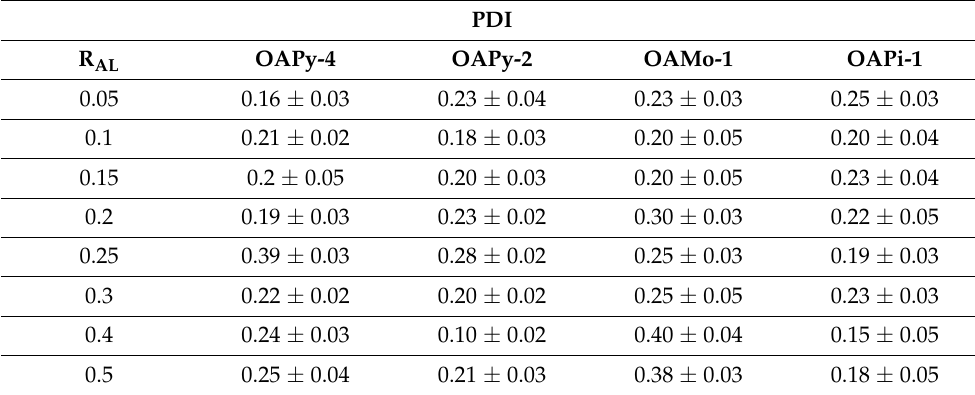
Table 2. Particle size distribution as expressed by polydispersity index (PDI) for nanoformulations prepared by adding aminolipids to MO dispersed with stabiliser Pluronic F-127. The amount of aminolipid added to the formulation is represented by R AL , which is defined as the wt./wt. ratio of aminolipid to total lipid. Data are reported as the mean ± standard deviation (n =